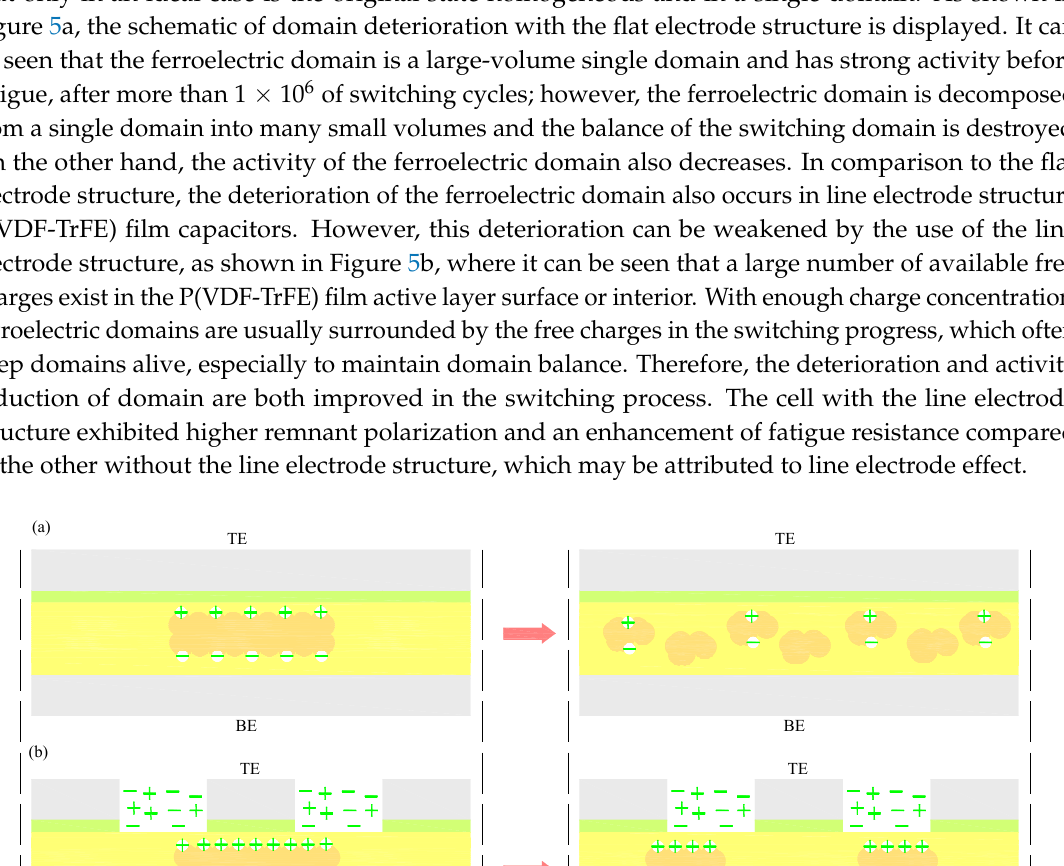
Table 2. Driving voltage test result with different electrode structures.